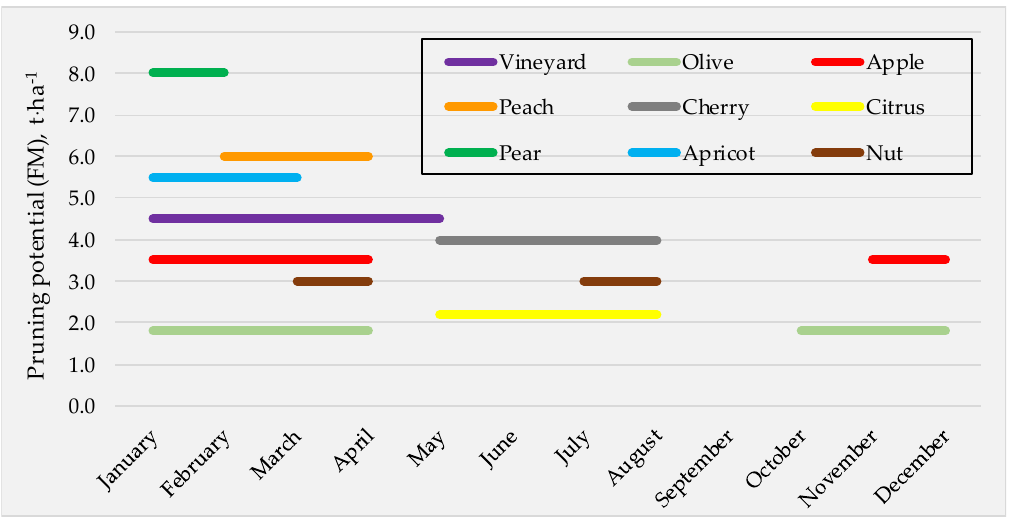
Figure 1. Average pruning potential from different permanent crops [13].